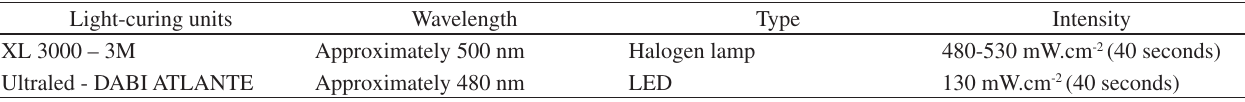
Table 1. Light-curing units tested.